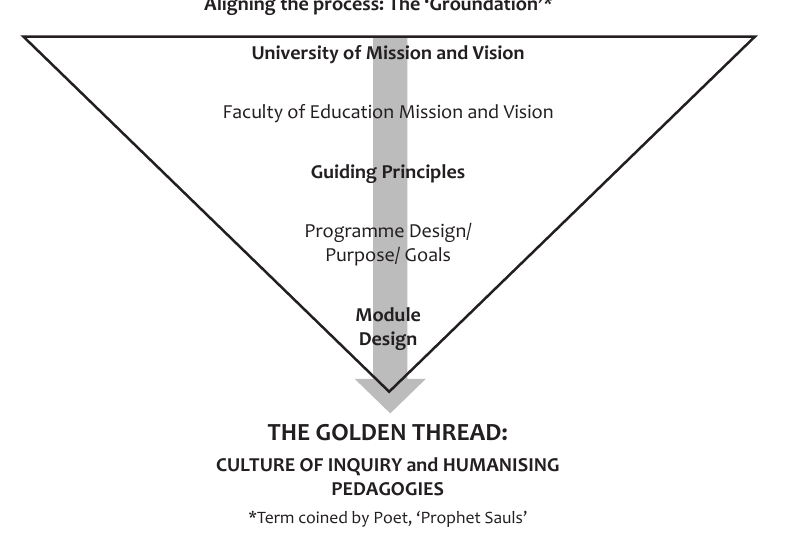
Figure 1: The ‘Groundation’ (NMMU 2011) This part of the renewal process was characterised by a series of inclusive